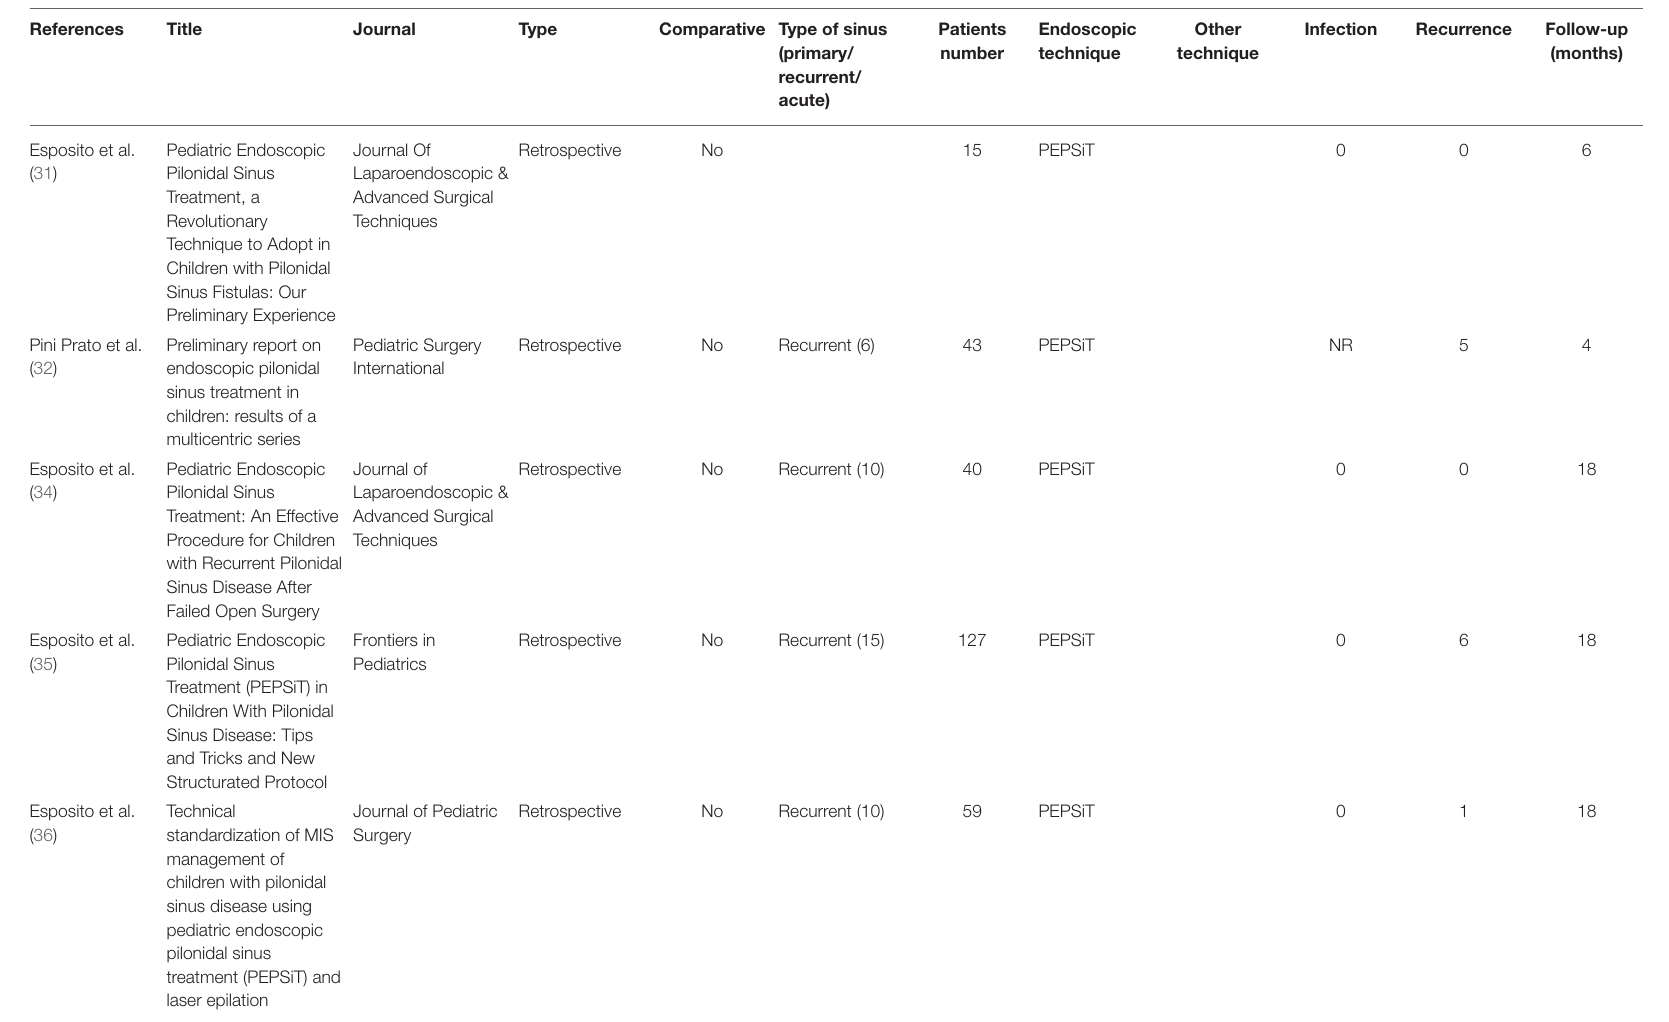
TABLE 3 | Cohort studies on endoscopic treatment in the pediatric